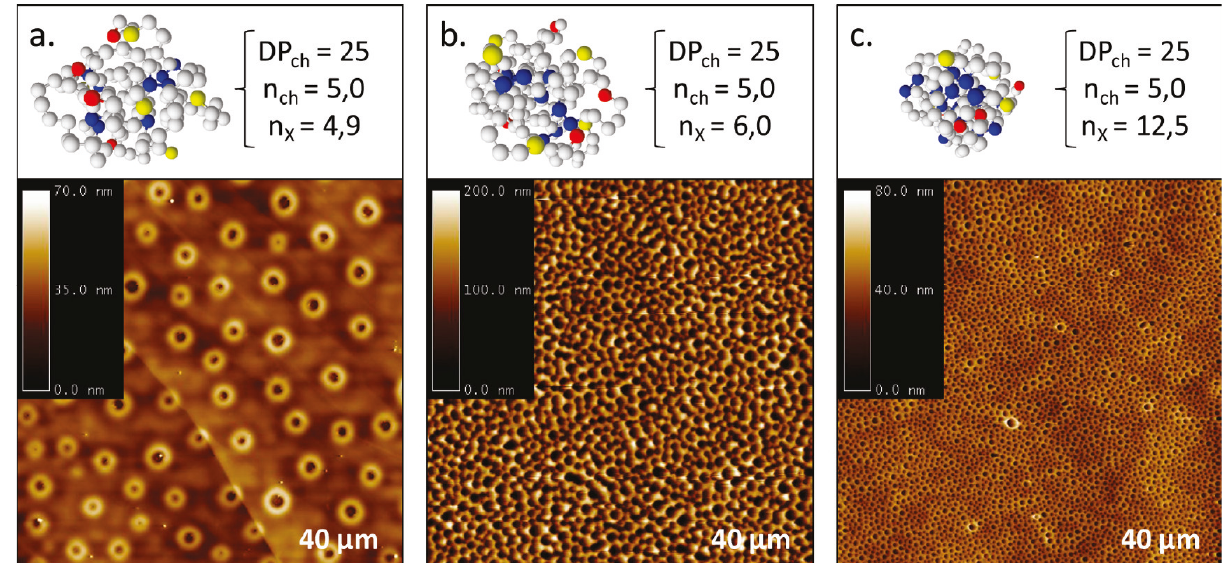
Figure 13. AFM topography images for films prepared by spin coating, on graphite, nanogel solutions in THF/H O (98/2 vol %/vol %) at a concentration of 10.0 mg/mL. 2 (Inset) Theoretical structure. DP : degree of polymerisation of the constitutive chains. n ch average number of constitutive chains. n : average number of cross-links. ( a ) Nanogel 1 x (x = 7.87%). ( b ) Nanogel 2 (x = 9.60%). ( c ) Nanogel 3 (x = 20.03%). Reproduced with permission from Poly et al. Langmuir 2011 , 27 , 4290 [181]. Copyright 2011 American Chemical